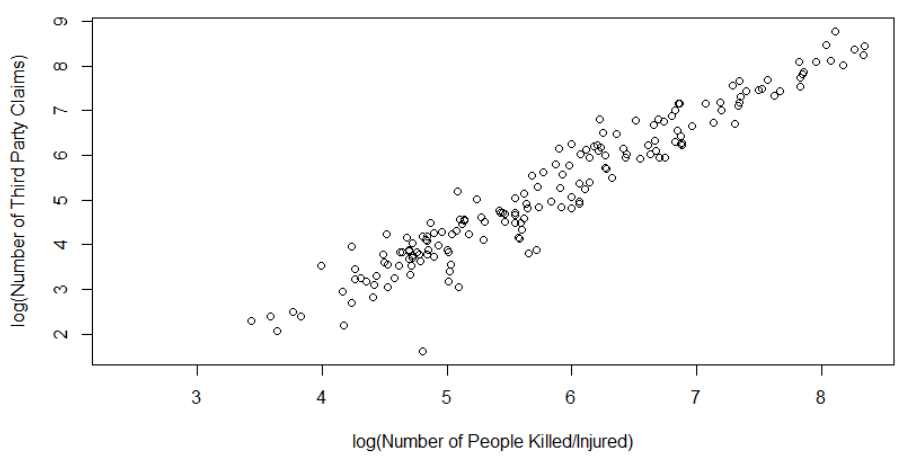
Figure 6. Scatterplot of the Model 4 data (on a natural log scale).